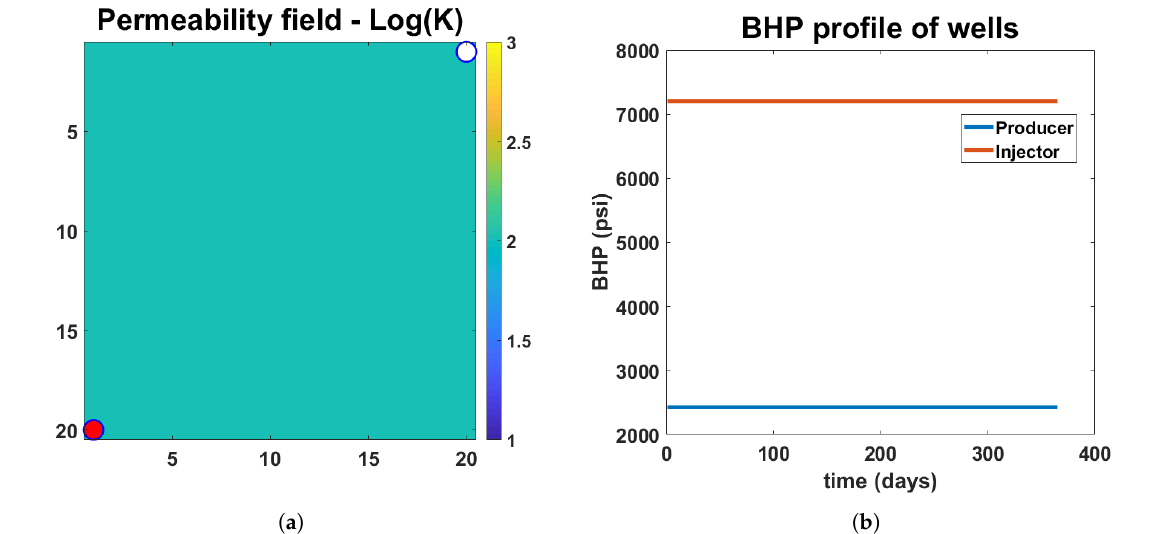
Figure 4. ( a ) Homogeneous permeability reservoir with 1 injector (white) and 1 producer (red). Producer is the parameter and can change location anywhere in the reservoir ( b ) BHP profiles of injector and producer that is set constant for all well configurations